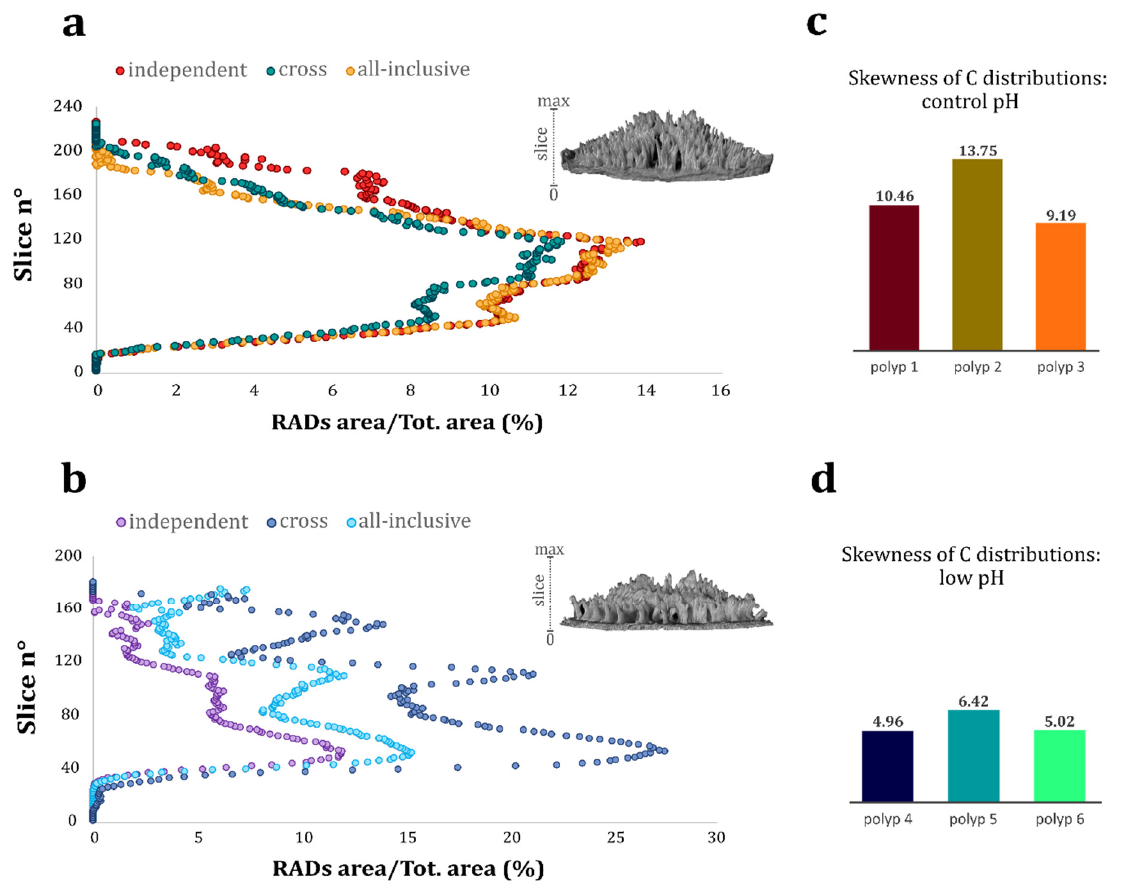
Figure 8. Evaluation of the DL-based segmentation performance based on the per-slice estimation of the area of the coral skeletal features and skewness of the distributions of the RADs-TDs shape configuration across samples. ( a , b ) Measured per-slice area of RADs over the total area of the skeleton (RADs + TDs) estimated using independent, cross, and all-inclusive segmentations (as shown in Figure 7) in the case of a control pH sample ( a ) and a low pH sample ( b ). The slice number indicates the progression through the recruit’s skeleton going from the base to the top, as illustrated by the coral skeletons on the right side of the graphs. Note how, for both control and low pH datasets, the per-slice area of the RADs obtained with all-inclusive segmentation gets closer to the value obtained with independent segmentation (red dots versus yellow dots and purple dots versus light blue dots, respectively) compared to the per-slice area obtained with cross segmentation (red dots versus green dots and purple dots versus blue dots, respectively). ( c , d ) Skewness of the distributions of the per-slice RADs-TDs shape configuration in control pH ( c ) and low pH ( d ) samples (see also Supplemental Figure S3). The ratio of the RADs perimeter/area over the TDs perimeter/area (“C”) was computed as an estimate of the relative shape of the skeletal features across the recruit skeletons. The skewness values are used as a metric to evaluate the degree of the RADs-TDs shape variation across datasets.